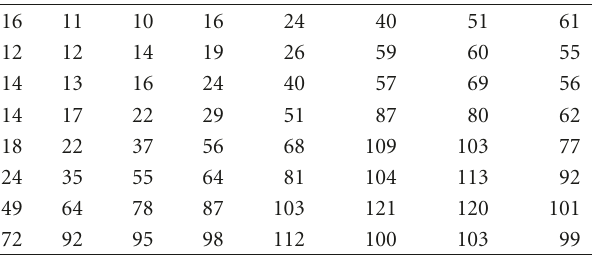
Table 1: JPEG quantization table for the luminance channel.